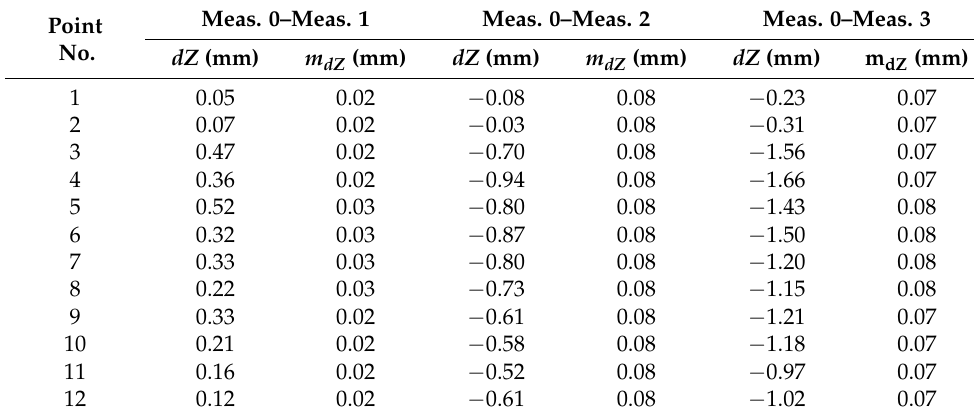
Table 3. The values of vertical displacements and their mean errors.